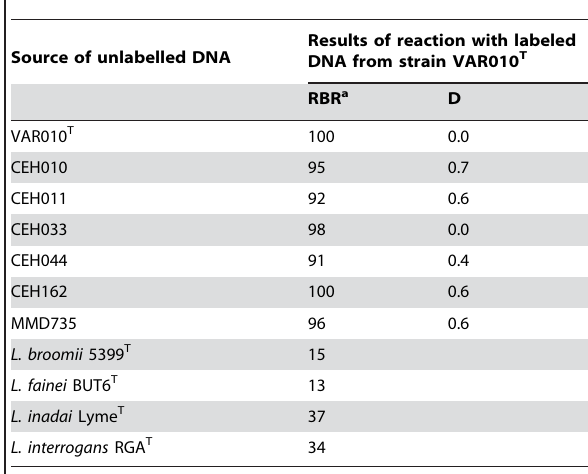
Table 1. DNA relatedness of ‘‘ Leptospira licerasiae ’’ strain VAR010 T to other Leptospira species: L. broomii 5399 T , L. fainei BUT6 T , L. inadai Lyme T and L. interrogans RGA T